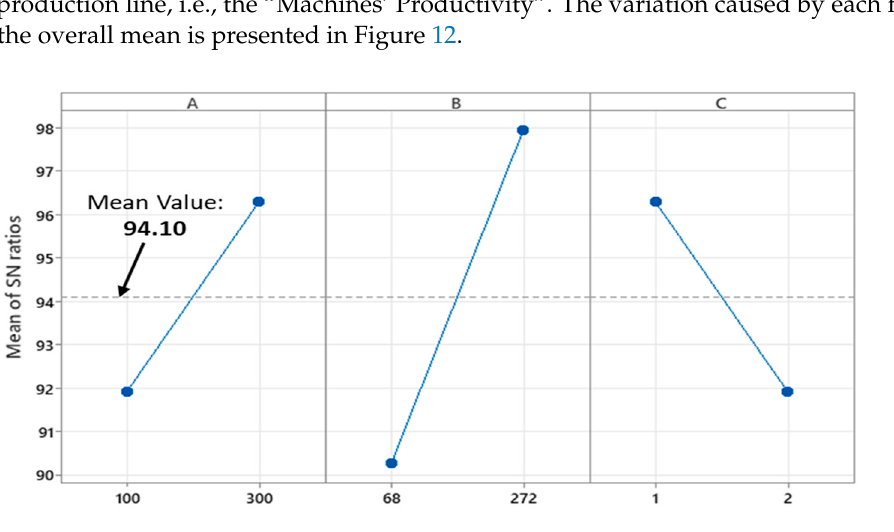
Figure 12. Main Effects Plot for SN ratios ( A ) Conveyor Velocity, ( B ) Machine’s Productivity, ( C ) Operator Number.